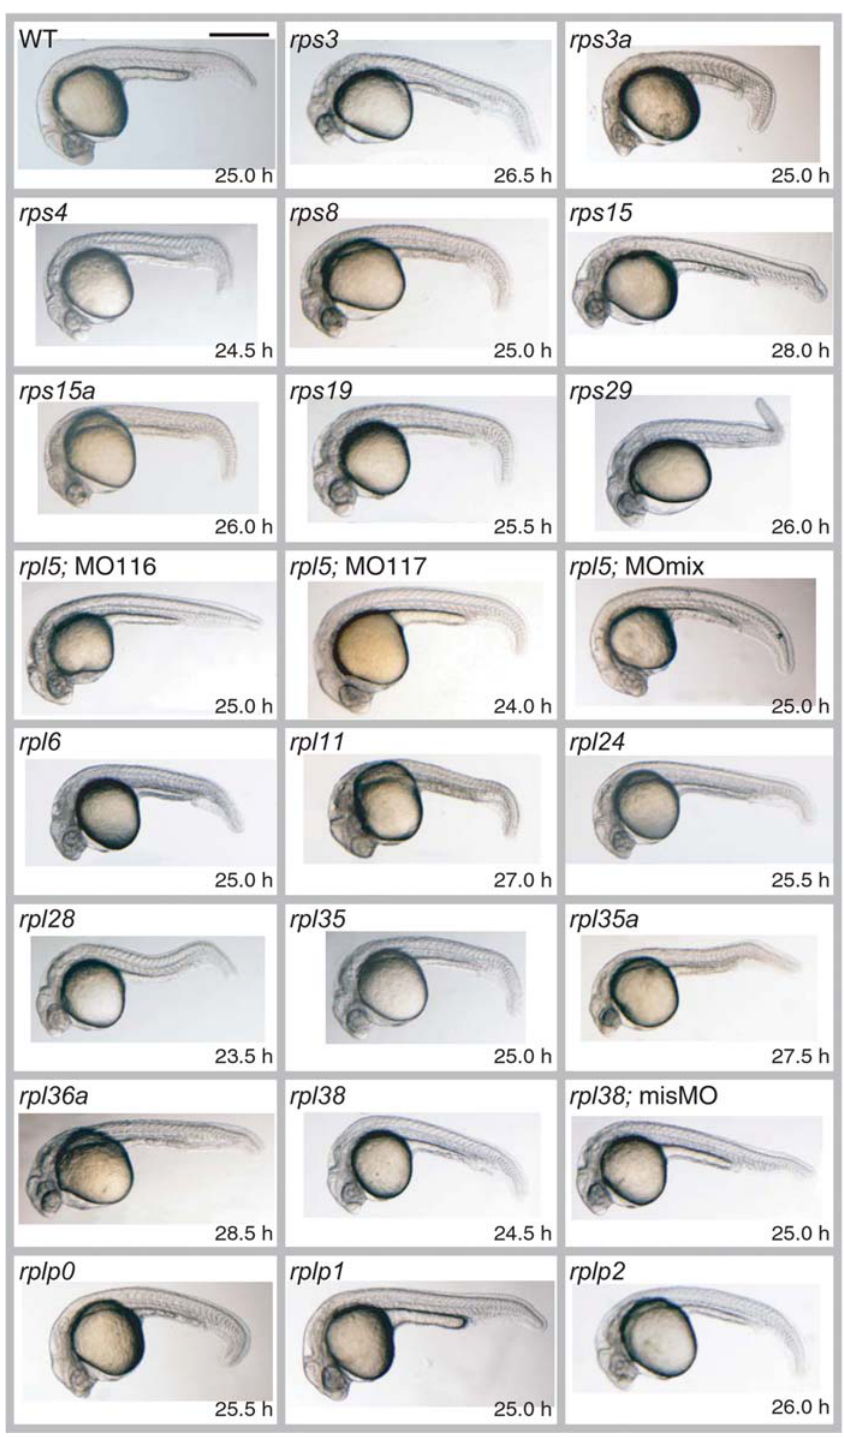
Figure 1. Lateral Views of Wild-Type and MO-Injected Embryos The genes targeted by MOs and the observation time are indicated for each image. ‘ rpl5 ; MO116’ and ‘ rpl5 ; MO117’ indicate two MOs designed and injected separately for two functional copies of rpl5 on the zebrafish genome. ‘ rpl5 ; MOmix’ indicates the mixture of MO116 and MO117. Control MOs that included 5 mispaired bases were also used; one example of a control MO injection is shown ( rpl38 ; misMO). Note that compared to the control, the rpl38 morphant is shorter and displays a light-colored eye and thin yolk sac extension. Scale bar, 500 m m.